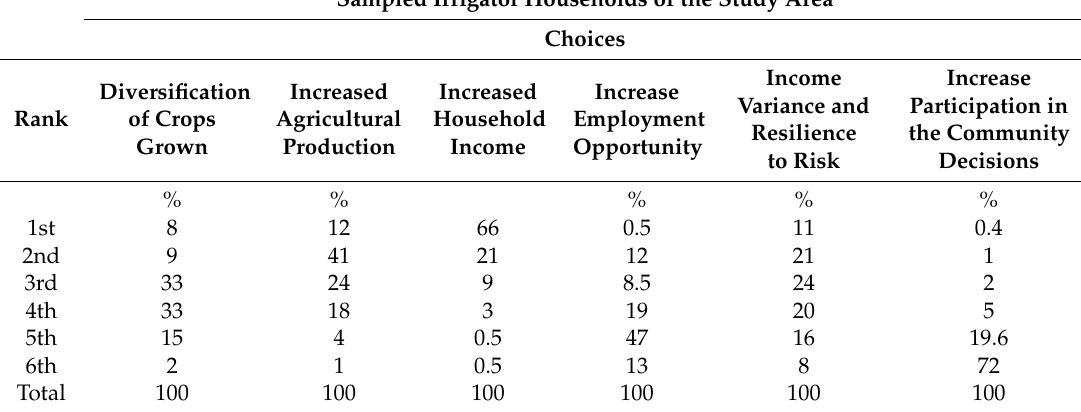
Table 8. Response of HHs on livelihood development (NB: 1 USD « 20